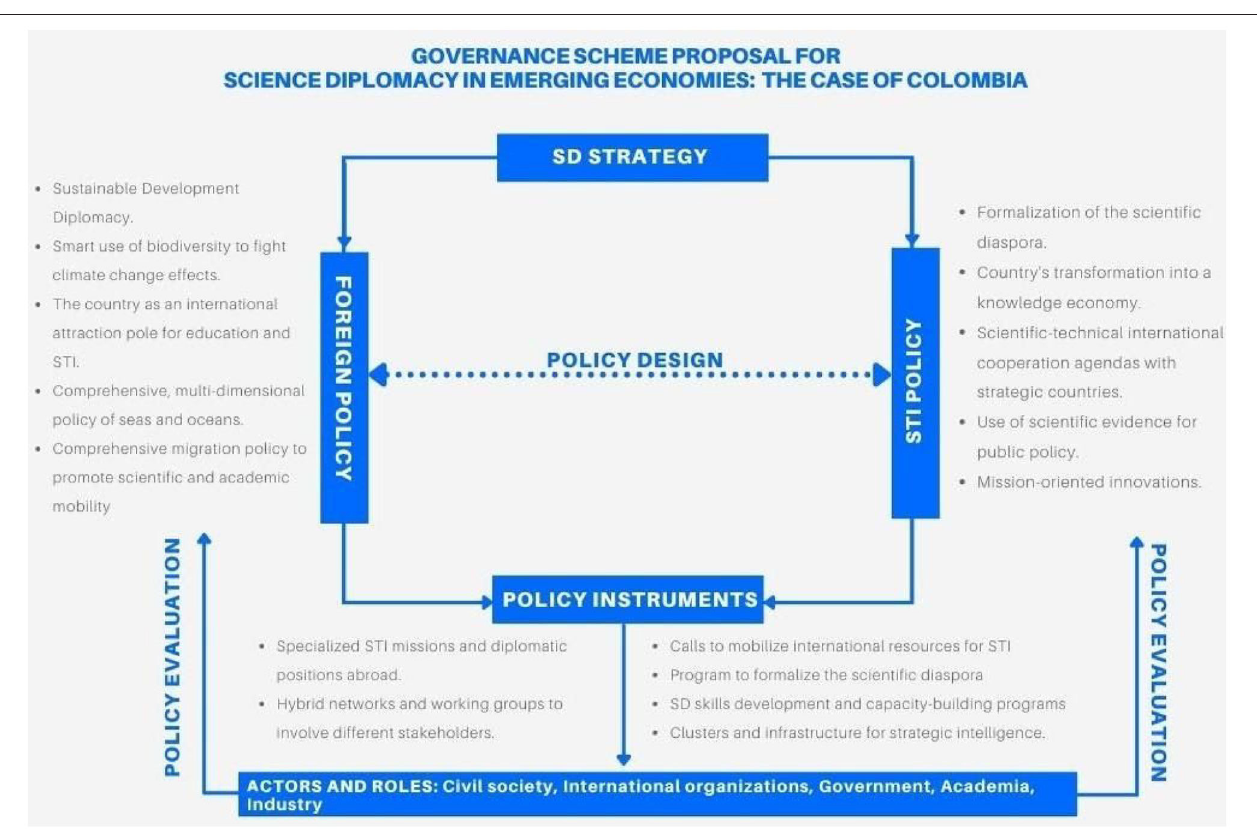
FIGURE 5 | Governance scheme proposal for SD in emerging economies based on the Colombian